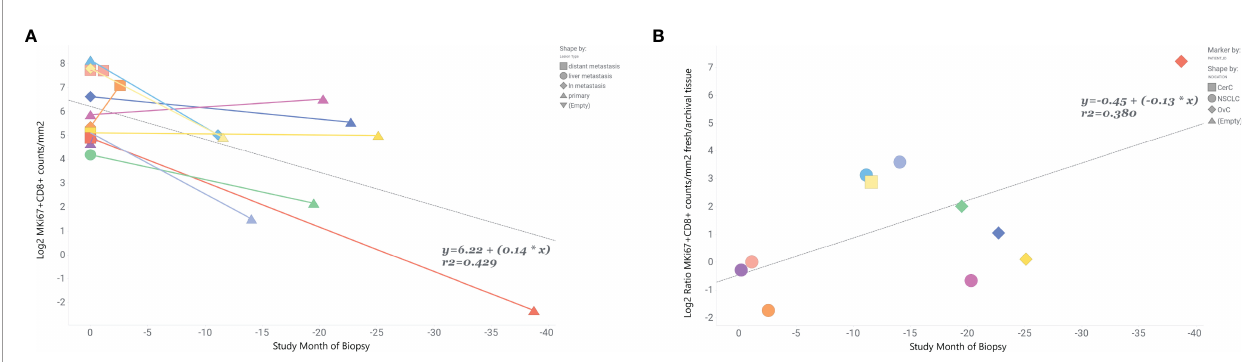
FIGURE 4 | MKi67+CD8+ levels are inversely related to time prior to fresh biopsy in paired fresh and archival samples. Ratio of fresh to archival levels increases with age of archival sample. In 11 paired fresh and archival samples biopsy dates were used to calculate the time archival tissue samples were collected relative to study start and collection of fresh tissue. Fresh tissue is at study month=0. (A) Linear correlation of Log2 MKi67+CD8+ cell counts/mm 2 and study month of biopsy collection. Colored lines connect tissue samples from the same patient. Data points are shaped by lesion type. (B) Correlation of Log2 MKi67+CD8+ ratio Fresh/ Archival tissue from the same patient. Data points are shaped by patient ’ s indication. Additional clinical variables are provided in Supplemental Table 5